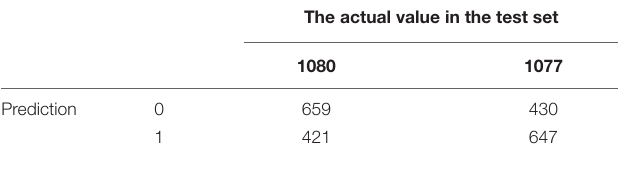
TABLE 4 | Confusion matrix of random forest (RF).